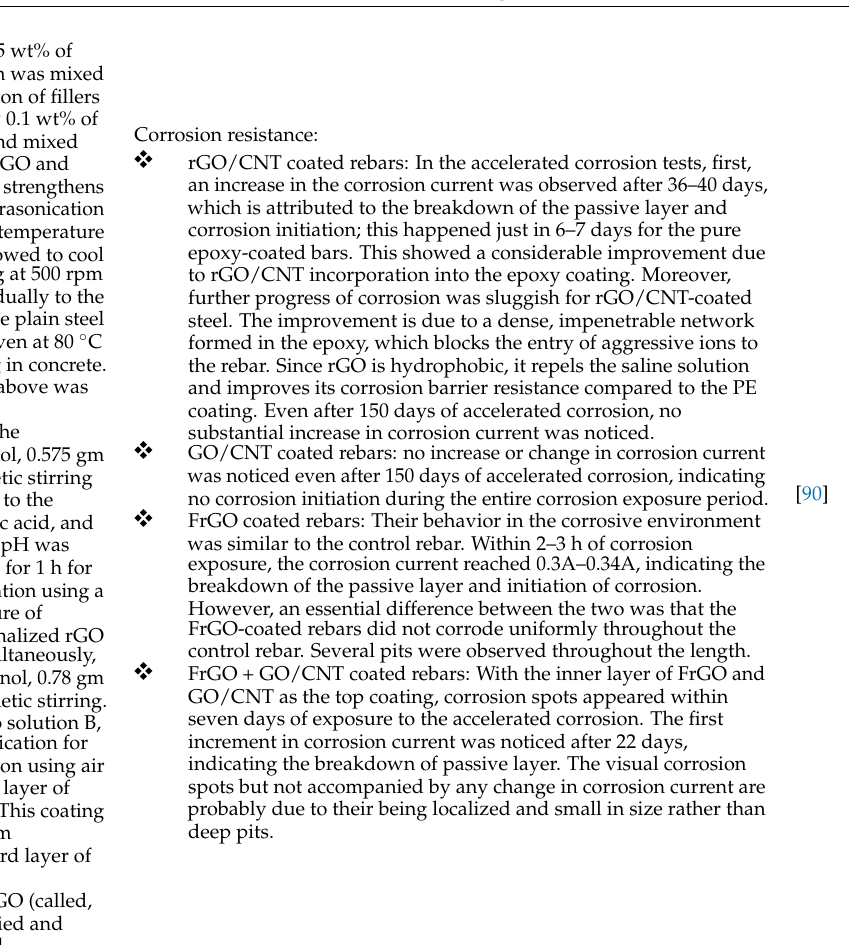
Table 1. Different approaches for improving silane coatings and the main findings, as reported in the literature.